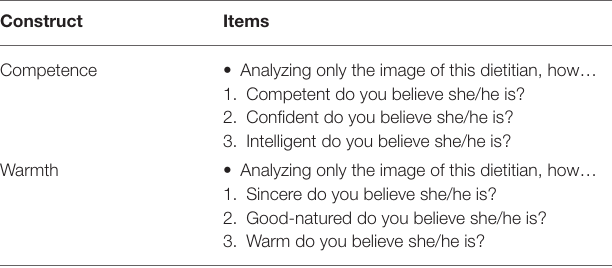
TABLE 1 | Items in the abbreviated “SCM” questionnaire assessing competence and warmth.